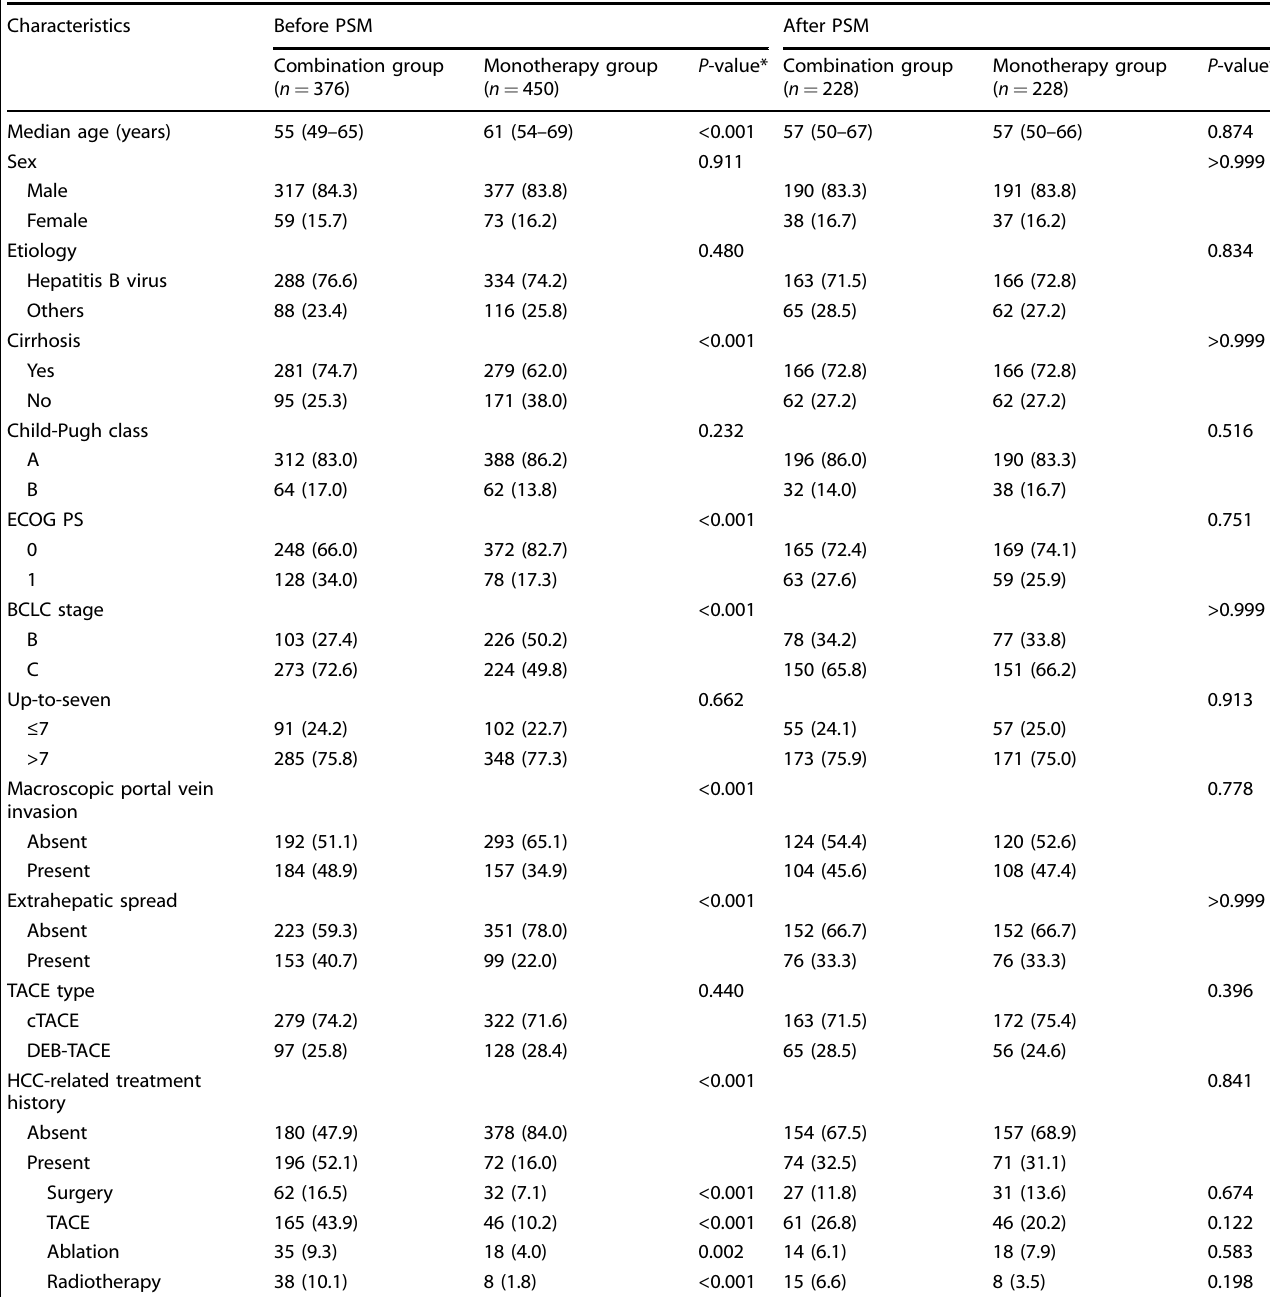
Table 1. Patient baseline characteristics of combination and monotherapy groups before and after PSM